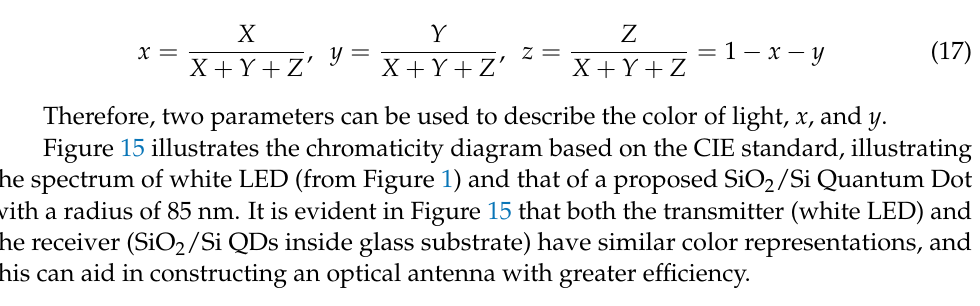
Figure 14. CIE 1931 profiles for blue, green, and red channels. With Equation (17), it is possible to normalize the X , Y , and Z values (although it may lose information regarding the brightness (amplitude) of the light).